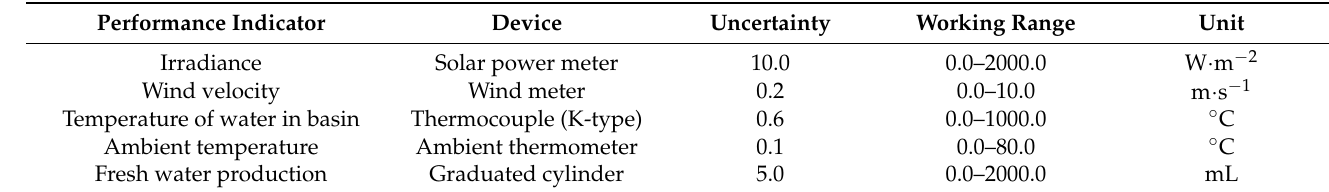
Table 1. The specifications of the measuring